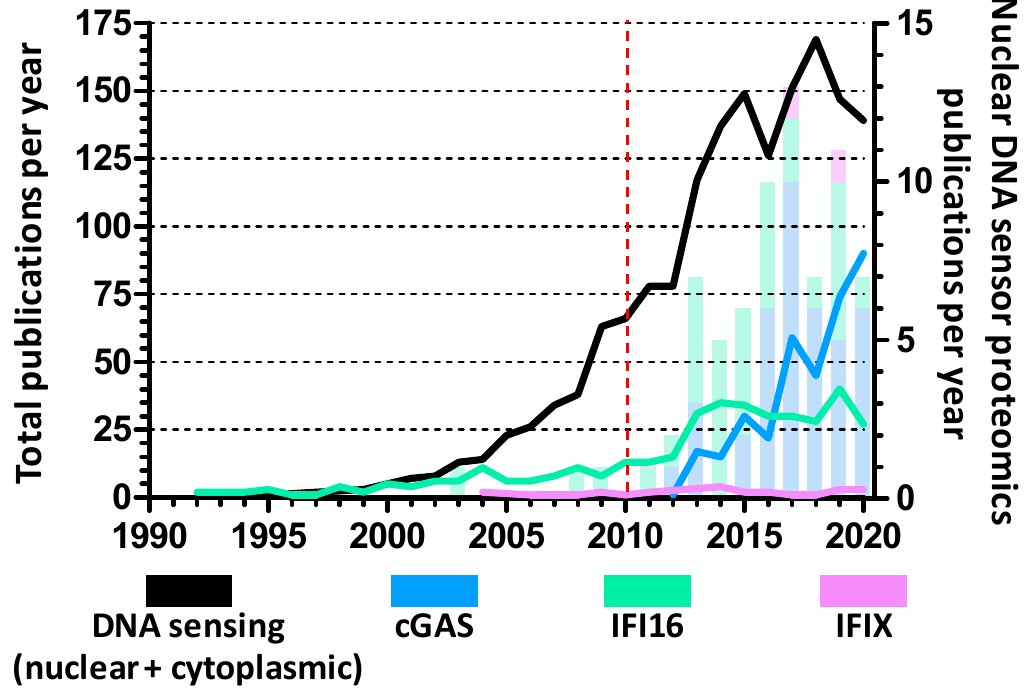
Figure 2. Yearly research articles investigating nuclear DNA sensors. Research papers focused on each nuclear DNA sensor, obtained from PubMed search when considering published research articles each year since 1990. The sum of each year’s articles for each protein is represented by line graphs (left Y axis) while articles specifically utilizing proteomics approaches to investigate proteome changes, protein–protein interactions, post-translational modifications, etc., are shown as stacked bars (right Y axis). Of note, the black line represents the number of articles concerning all kinds of DNA sensing, including non-nuclear sensors such as the cytoplasmic AIM2 and endosomal TLR9. The red dashed line marks the discovery of IFI16 as the first nuclear DNA sensor.